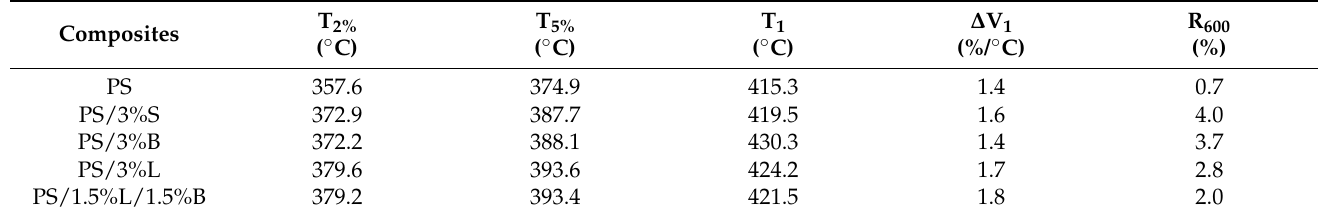
Figure 7. Results of mass change derivative curve analysis of PS polymer and composites based on PS. Table 5. The results of research on the properties of thermostability of